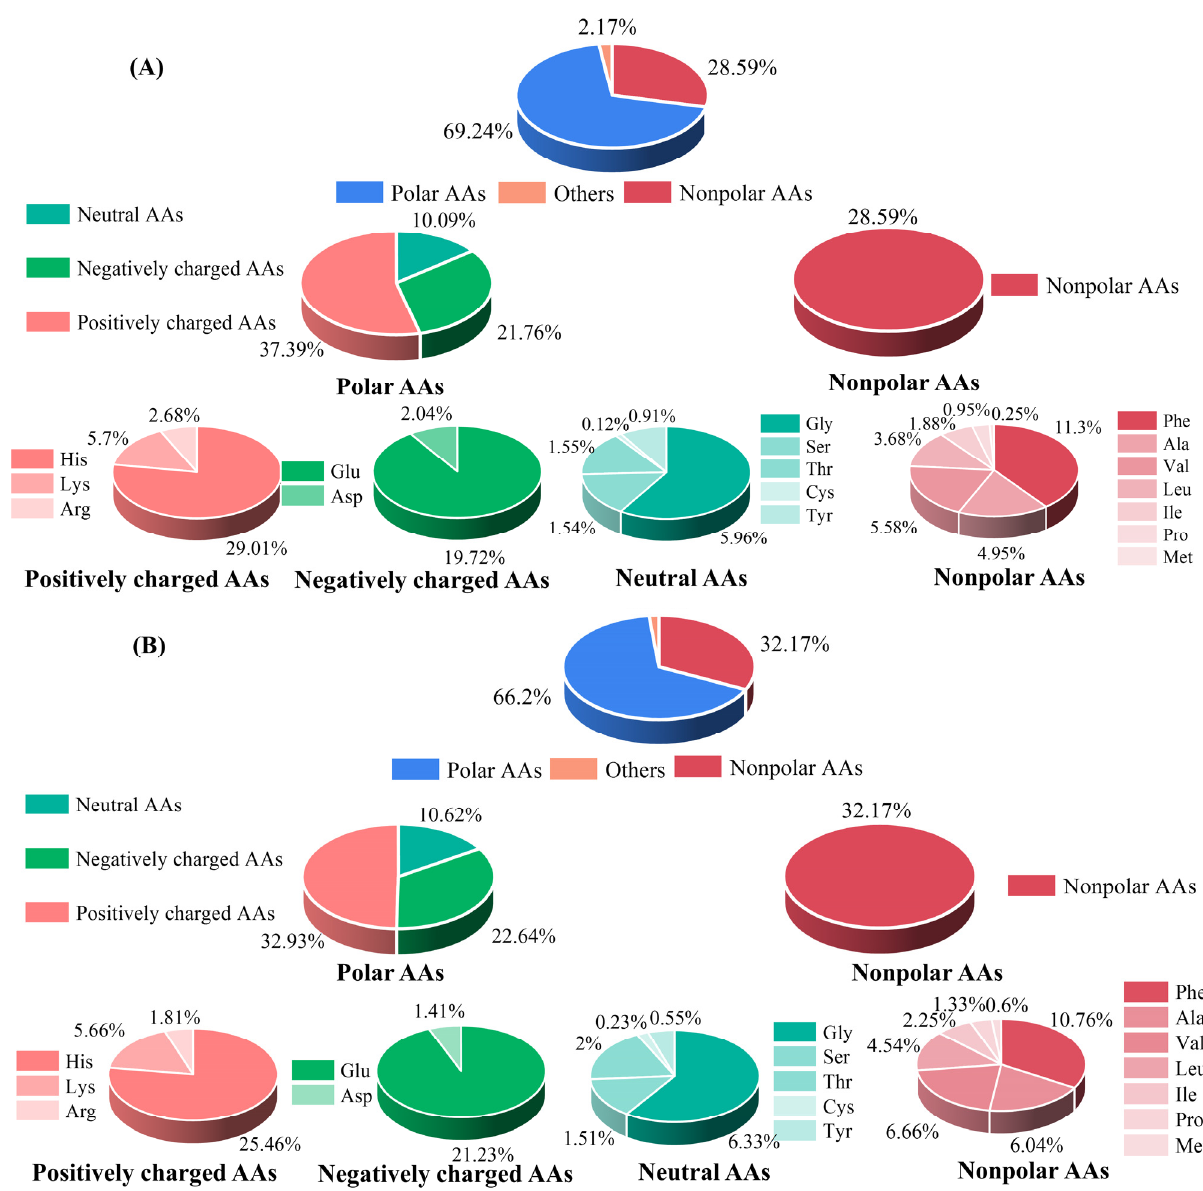
Figure 2. Amino acids profile of M1 ( A ) and M2 ( B